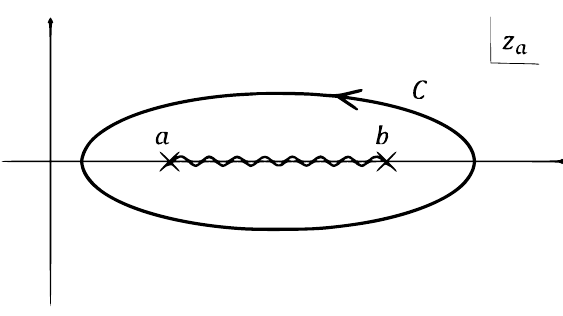
Figure 1 . Integration contour C on the complex z a